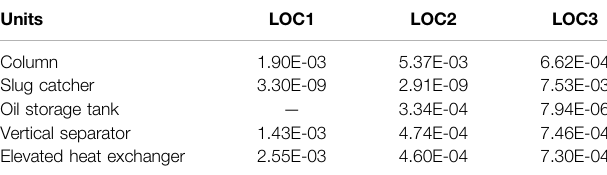
TABLE 7 | MAF of LOC events.